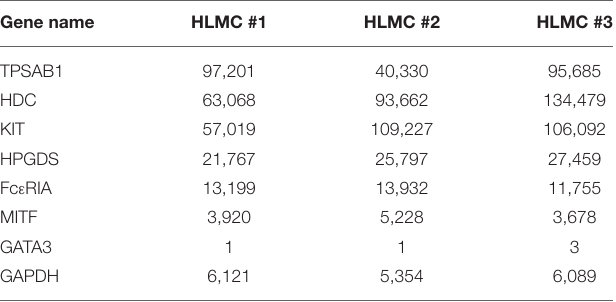
FIGURE 3 | Mast cell yield in Conventional and WEMP protocol. CD45 + CD117 high expressing Fc ε RI + mast cell yield compared between conventional and WEMP protocol. ** P <